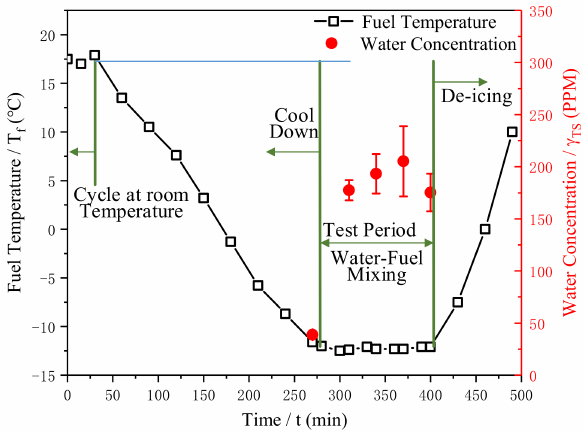
Figure 3. A typical fuel temperature and water concentration